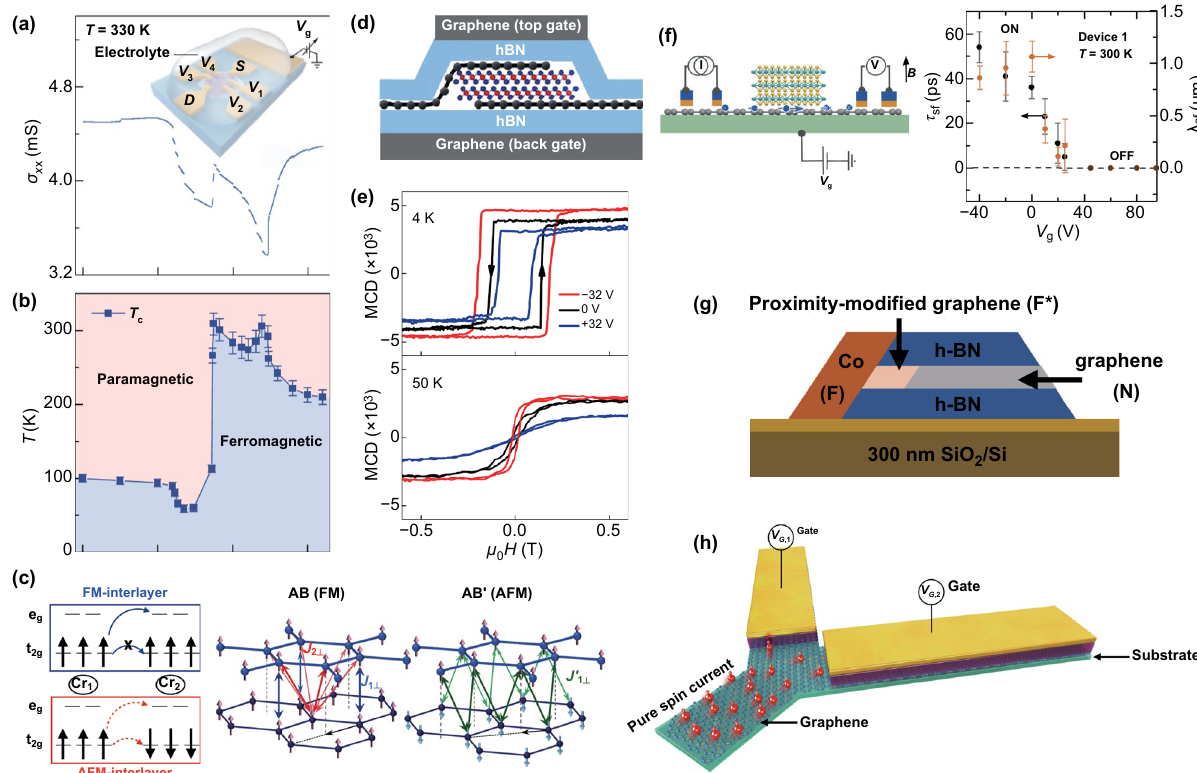
Fig. 8 a, b Ferromagnetism in an atomically thin Fe 3 GeTe 2 (FGT) flake modulated by an ionic gate. a Conductance as a function of the gate voltage Vg measured in a trilayer FGT device at room temperature. The inset shows a schematic of the FGT device structure. b Phase diagram of the trilayer FGT sample as the gate voltage and temperature are varied [99]. c Schematic of the orbital‑dependent interlayer super‑super‑ exchange interactions in CrI 3 [167]. d , e 2D CrI 3 field‑effect devices. d A schematic side view of a dual‑gate bilayer CrI 3 field‑effect device. e Magnetic circular dichroism versus magnetic field at three representative doping levels at 4 k (top panel) and 50 K (bottom panel) [163]. f Gate‑ controlled spin valve signal at room temperature [135]. g Schematic of the magnetic proximity effect for encapsulated graphene with a transpar‑ ent 1D edge contact to a ferromagnetic electrode [173]. h A Y‑shaped graphene spin current demultiplexer with gate voltages V G, i for voltage control of pure spin currents [175]. Figures reproduced with permission from Refs. [99, 135, 163, 167, 173,